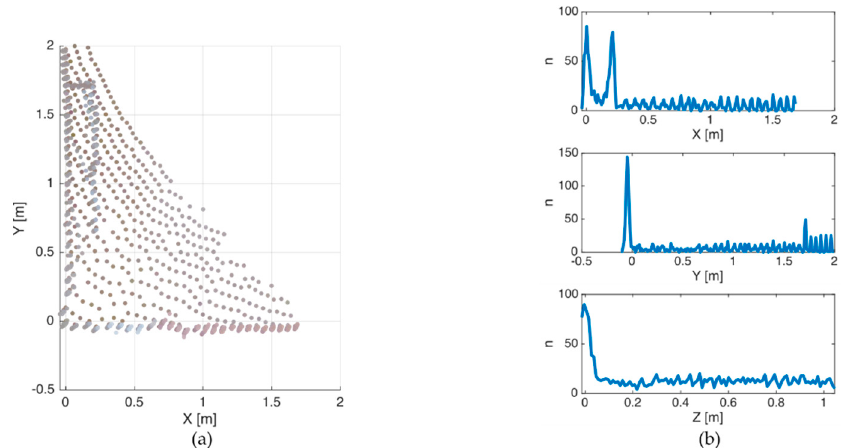
Figure 9. Point cloud with corrected orientation: ( a ) Output point cloud; ( b ) New histograms of point density in all coordinate axes.